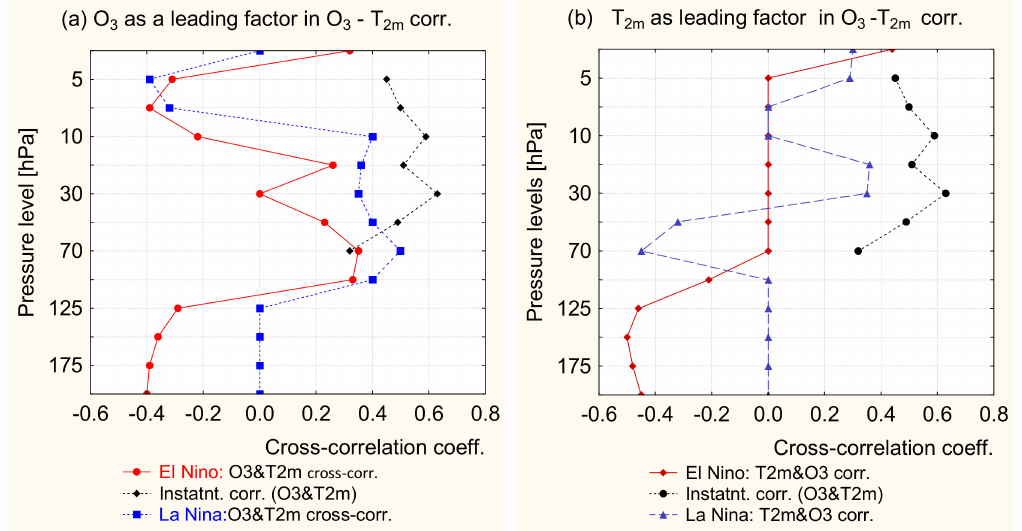
Figure 8. Cross-correlation coefficients of ozone profile in the Central Pacific (10 ◦ N, 170 ◦ W) with the temperature at 2 m above the surface (T 2m ), calculated for the period 1979–2019. The forcing factor in ( a ) panel is ozone, while in ( b )—the T 2m . The zero lag correlation (the black line), which is the strongest one, is not suitable to infer the causality of the O 3 -T 2m